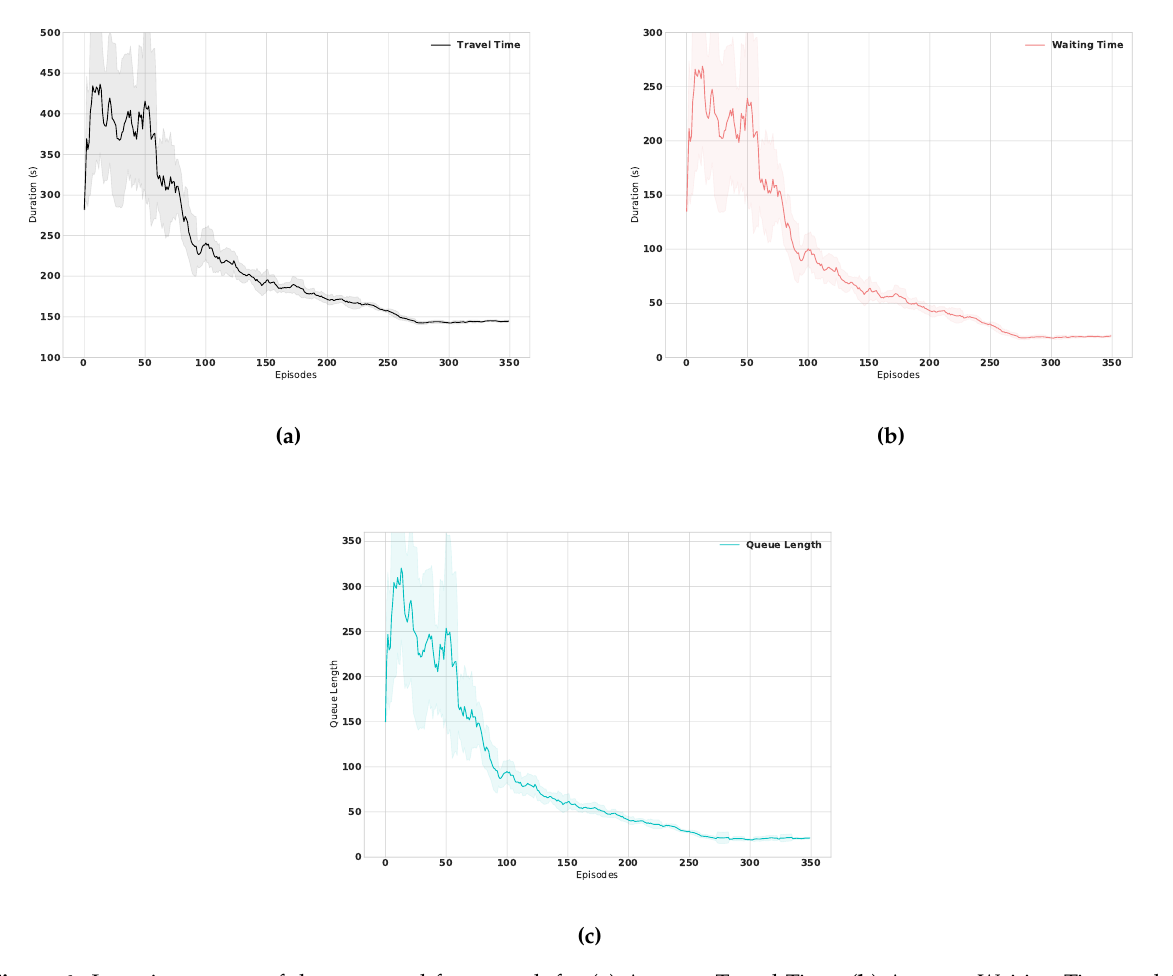
Figure 6. Learning curves of the proposed framework for ( a ) Average Travel Time, ( b ) Average Waiting Time and ( c ) Average Queue Length over